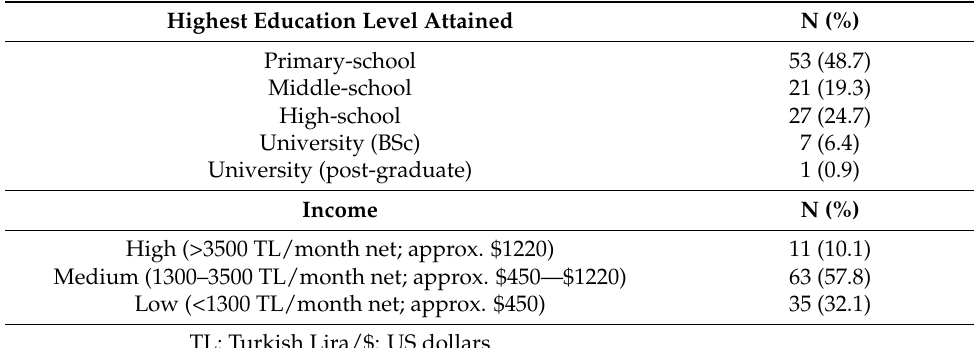
Table 1. Education and Income characteristics of participating mothers.